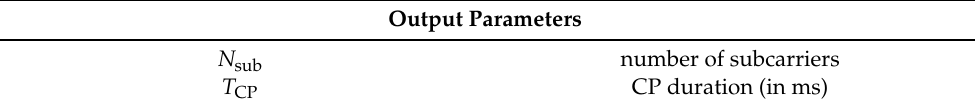
Table 2. Optimization output parameters.